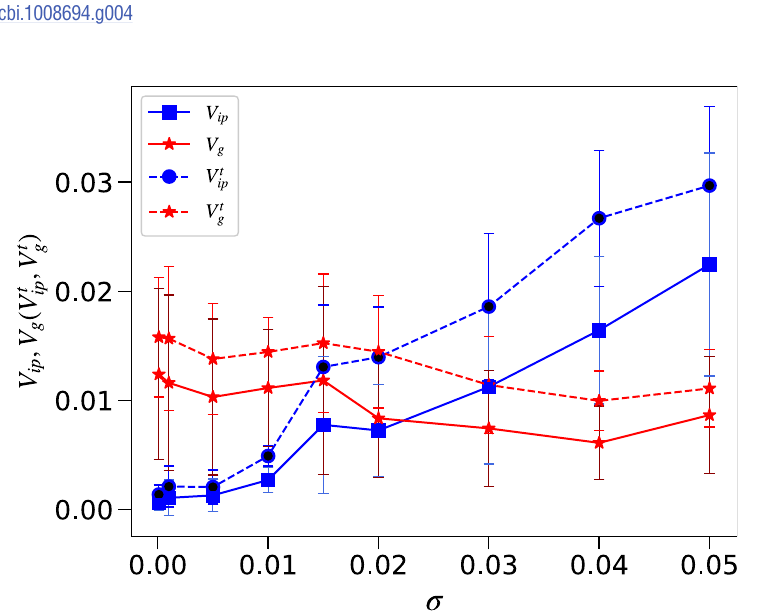
and V . Parameter values of σ and c for each ip g and V (see the text for details). ip g